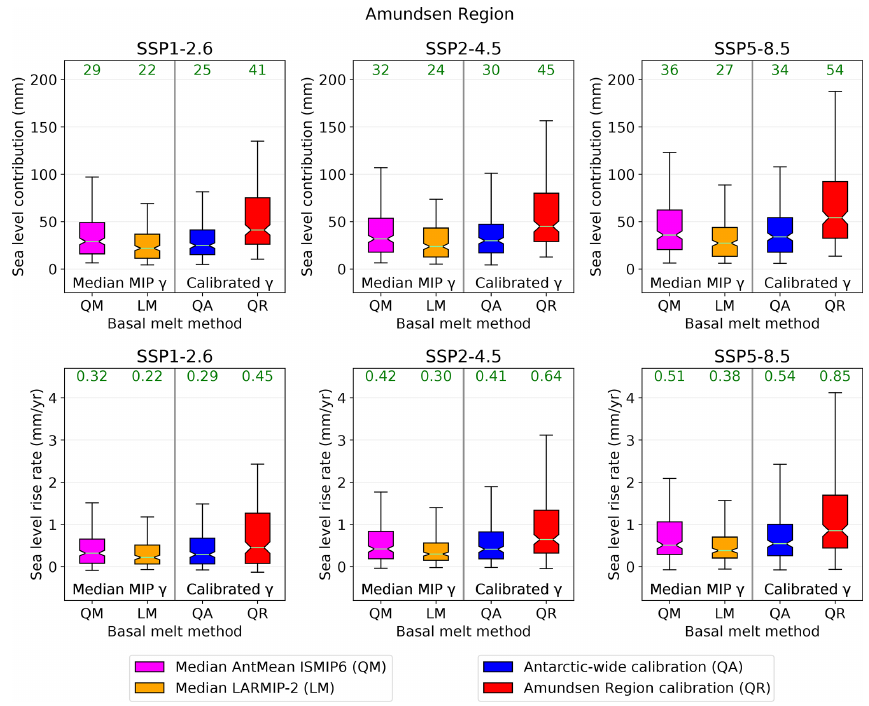
Figure 9. Same as Fig. 8 but for the Amundsen Region. Table 8. Projected dynamic contributions to sea level in metres from the AIS in 2100 relative to 1995–2014. The numbers for LARMIP-2, emulated ISMIP6 and surface mass balance (SMB) contributions are obtained from the IPCC AR6 report (Fox-Kemper et al., 2021, their Table 9.3). Note that in our table “Emulated ISMIP6 AR6 – excl. SMB” represents the “Emulated ISMIP6 total” minus the SMB contributions (estimated from the AR5 parametric Antarctic Ice Sheet SMB model) to allow comparison with our results, as our study only accounts for the dynamic response. The emulated ISMIP6 numbers also include the estimated historical dynamic response. The contribution of LARMIP-2 includes all ice sheet models and the historical dynamic response is incorporated in the method. The columns show the 17th, 50th and 83rd percentiles of the